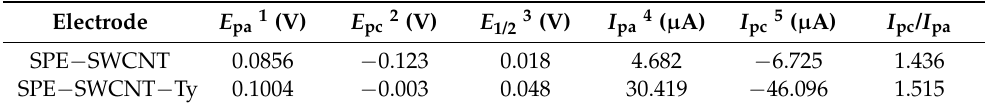
Table 1. The values of the parameters obtained from the cyclic voltammograms of all the